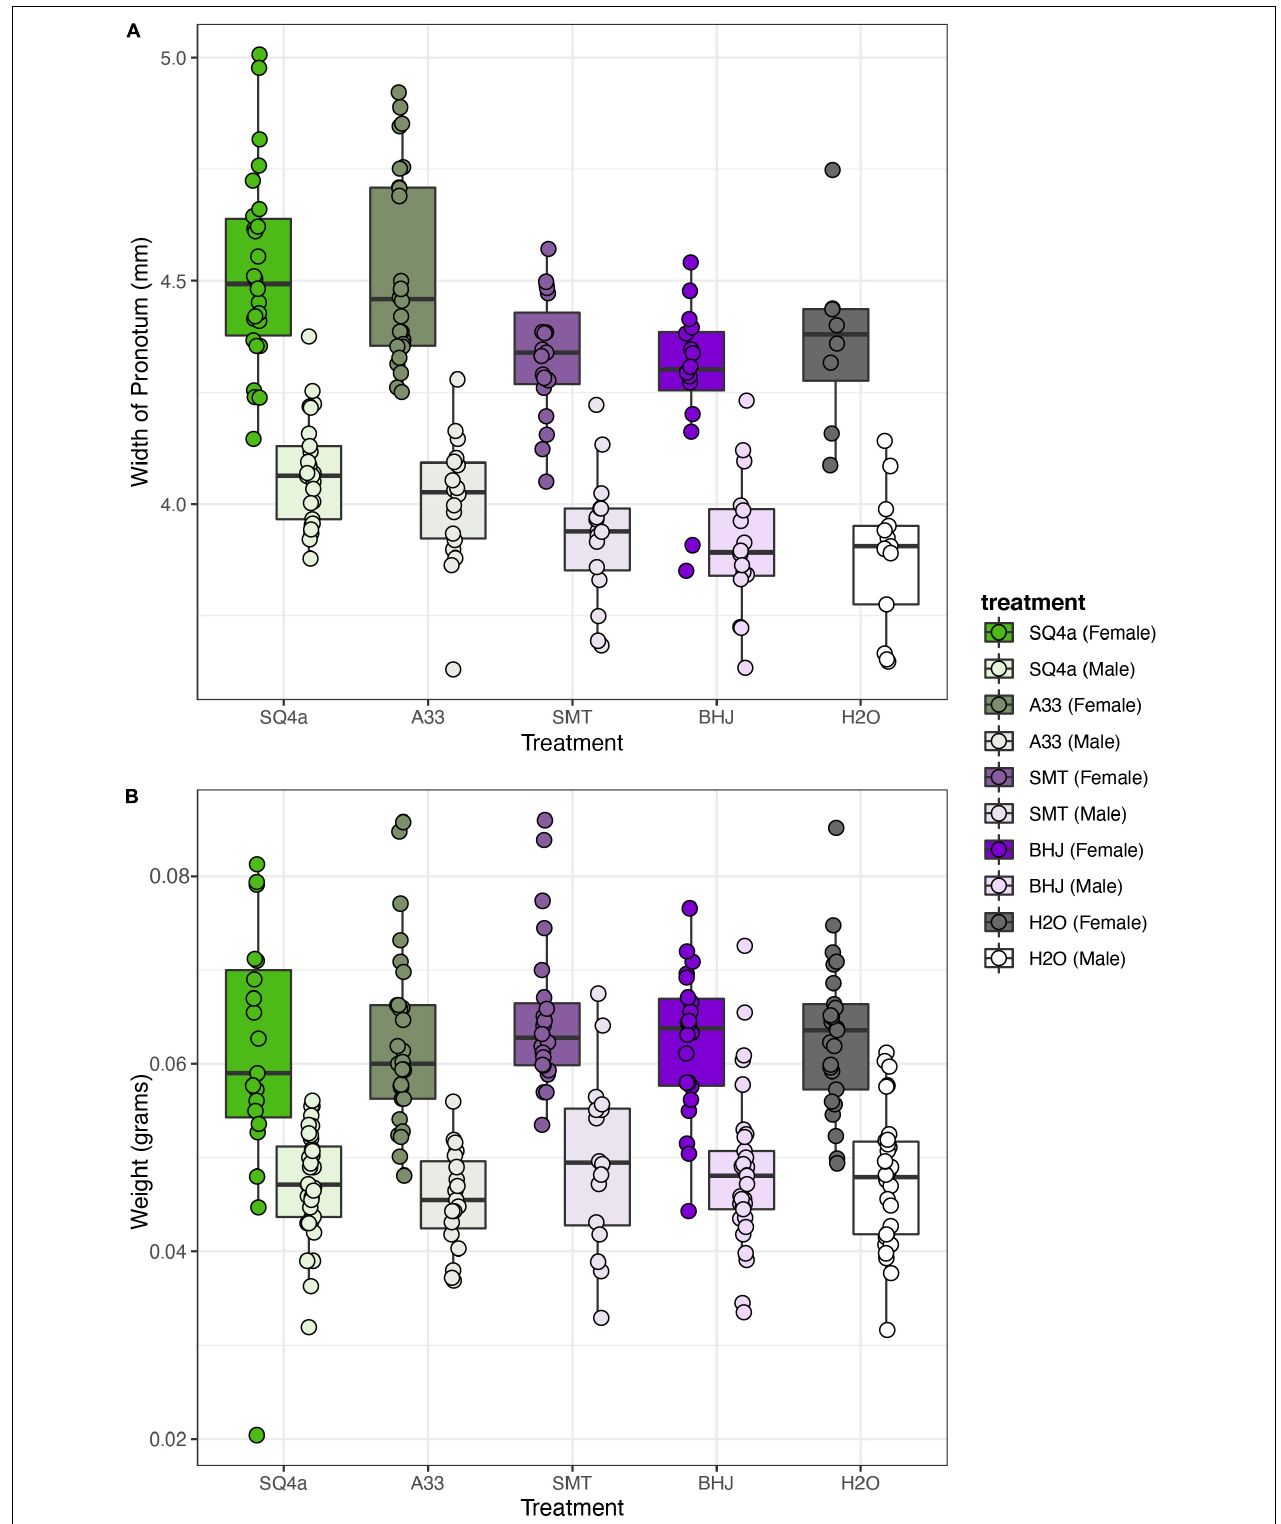
FIGURE 9 | Bacterial treatment significantly influences size but not weight of adult squash bugs. (A) Based on the width of the pronotum, females were larger than males, and, overall bugs inoculated with SQ4a and A33 were significantly bigger than individuals fed SMT, BHJ, and water. (B) Females were heavier than males, but there was no overall effect of bacterial treatment on adult wet weight. Each point represents the estimate for one individual.